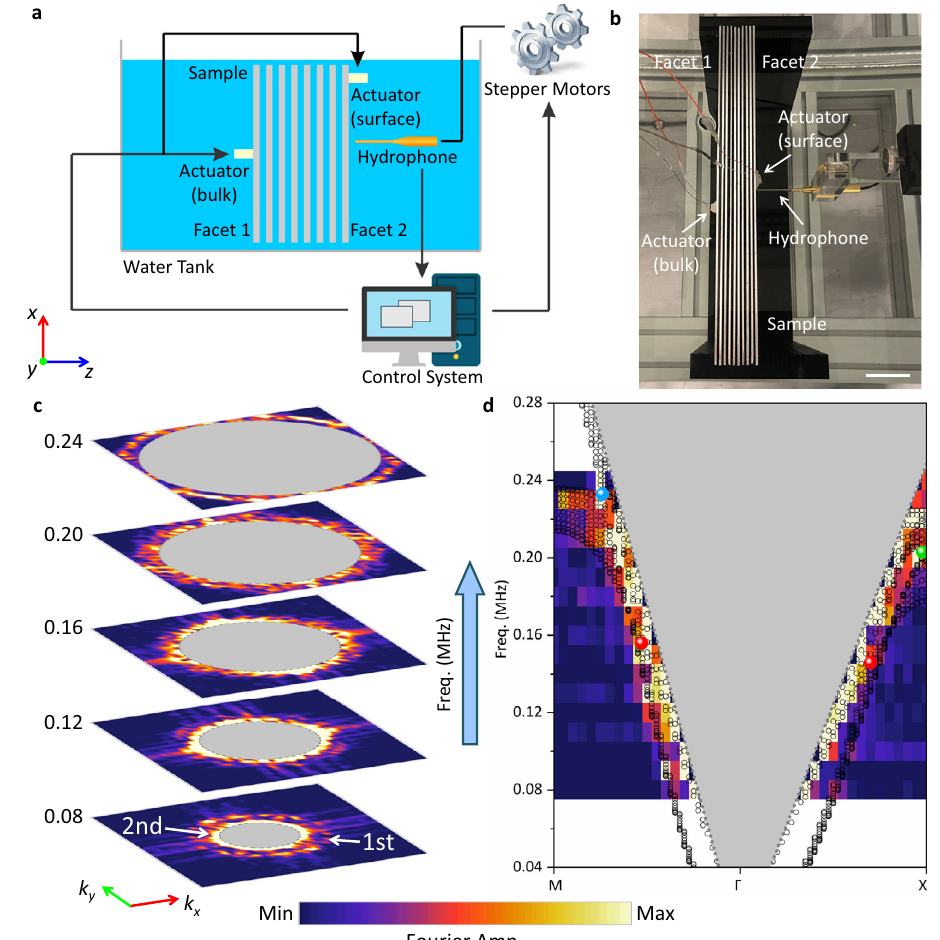
Fig. 3 | Experimental observation of type-II nodal rings. a Schematic of experi- mental setup for near- fi eld scanning. A hydrophone is employed to image the ultrasound signal at facet 2. Piezoelectric actuators are used to actuate the pho- nonic crystal. When detecting bulk bands, the actuator attached on facet 1 is excited, while detecting the surface states, the actuator attached on facet 2 is excited. b Photograph of the sample and experimental setup. White scale bar: 40mm. c Spatial Fourier spectraofexperimentally imaged fi elds atcorresponding